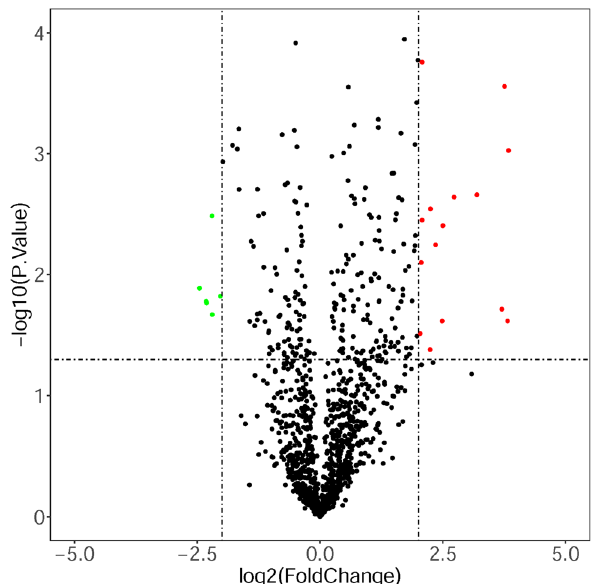
Figure 2. The DE-miRNAs between bleomycin-treated samples and control samples. A |log2FC|> 2 and P < 0.05 were set as the thresholds for identifying DE-miRNAs. The red and green dots represent the upregulated and downregulated miRNAs in bleomycin-treated samples, respectively; the black dots represent miRNAs that were not differentially expressed between the bleomycin-treated samples and control samples.